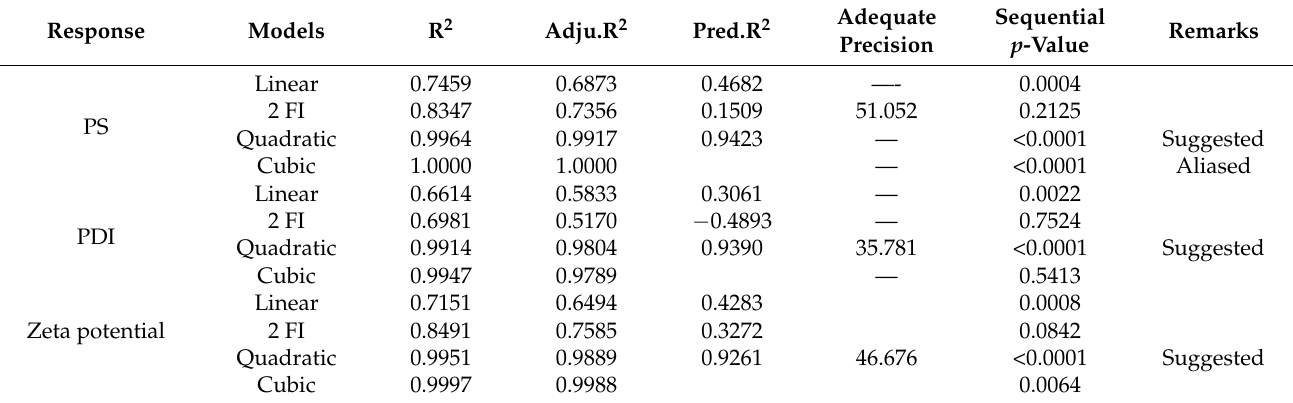
Table 3. Model statistical